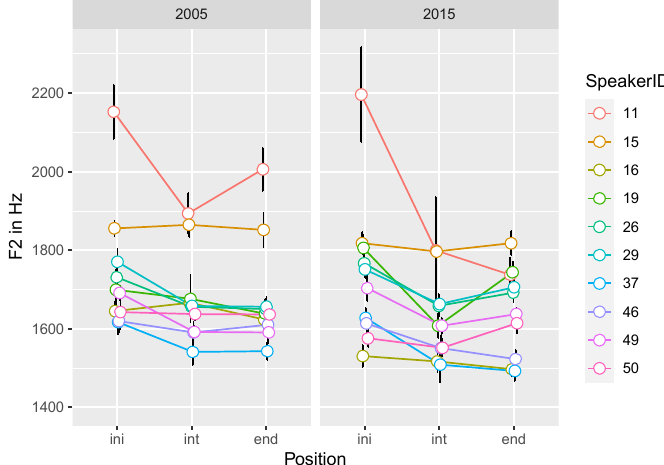
Figure A2. Speaker-specific data for F2.